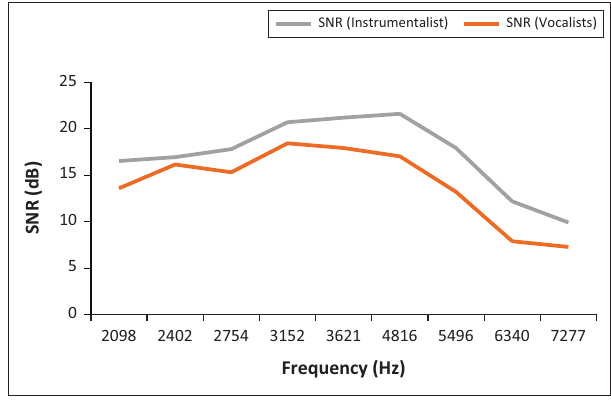
SNR, signal to noise ratio. FIGURE 1: Distortion products otoacoustic emission signal to noise ratio for instrumentalists and vocalists (left